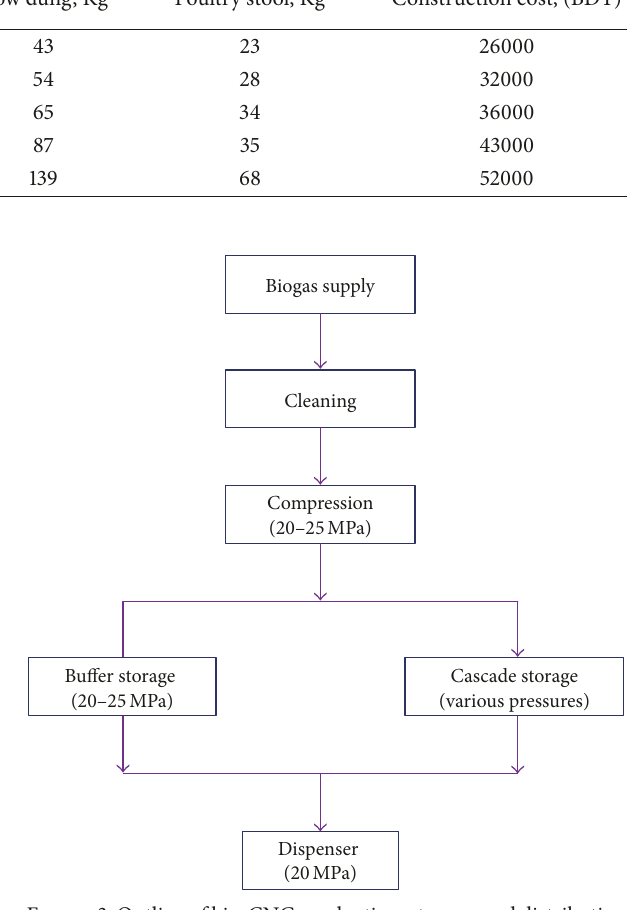
Figure 3: Outline of bio-CNG production, storage, and distribution